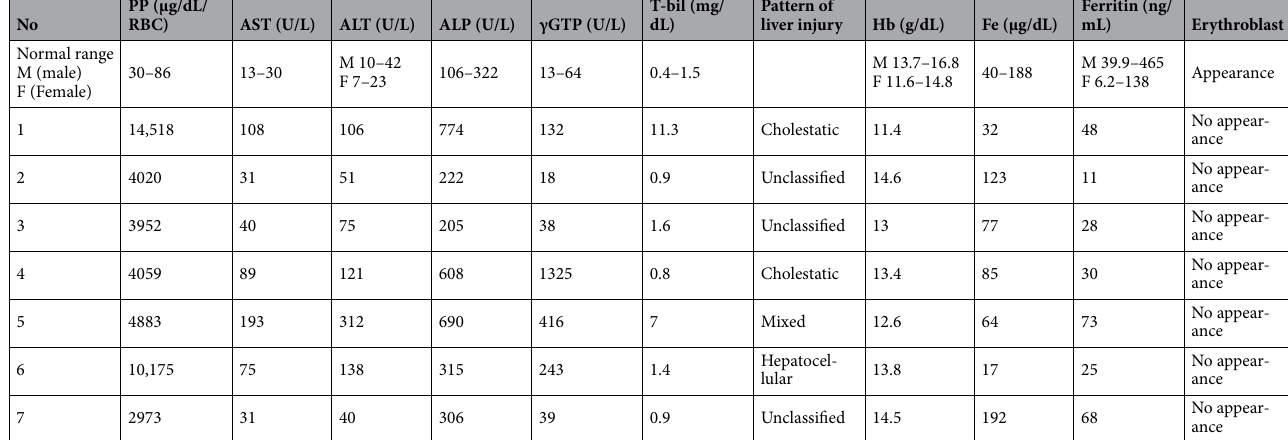
Table 3. Liver function and iron metabolism at the first visit. PP protoporphyrin, AST aspartate aminotransferase, ALT alanine aminotransferase, ALP alkaline phosphatase, γGTP γ-glutamyl transpeptidase, T-bil total bilirubin, Hb hemoglobin.